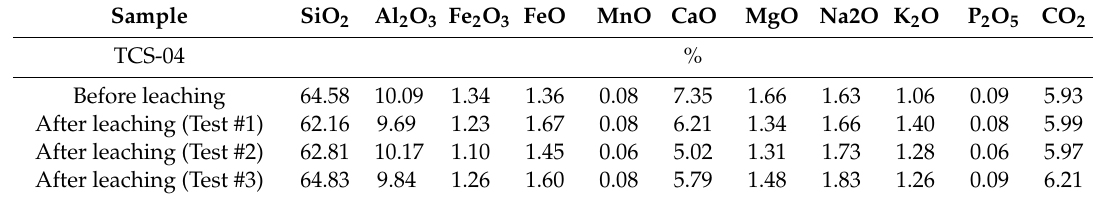
Figure 5. Change in uranium recovery in the leaching solution. Table 8. Geochemical analysis of ore and residues. Table 8. Geochemical analysis of ore and residues.